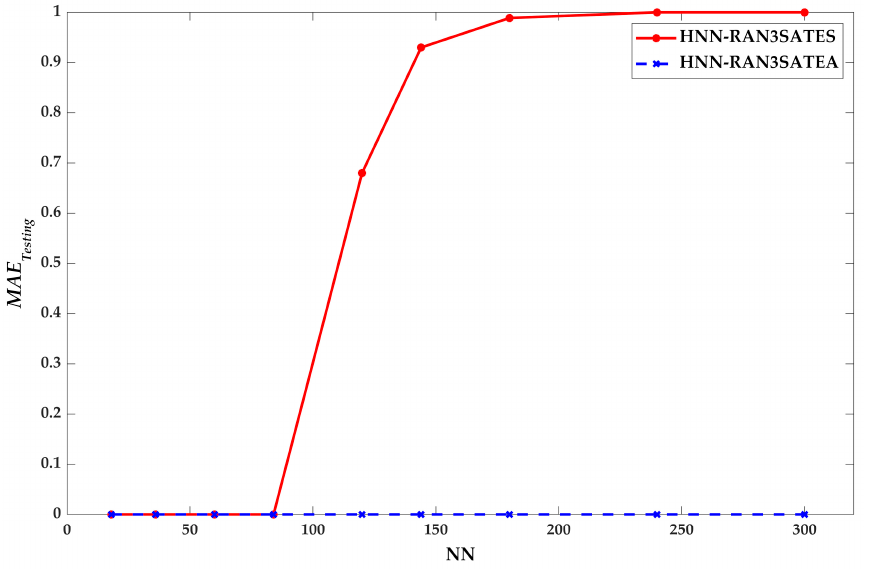
Figure 7. Testing MAE for HNN-RAN3SAT model.